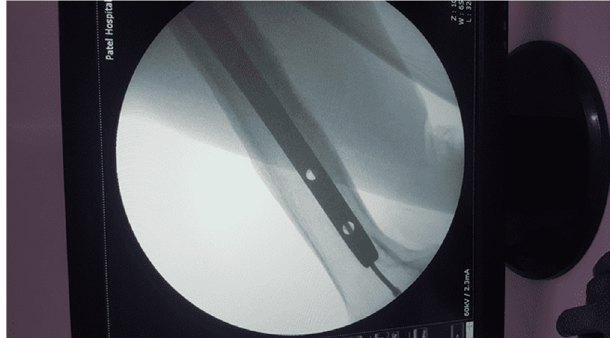
Figure 3. Ball tipped guidewire inserted through a broken segment of the nail.